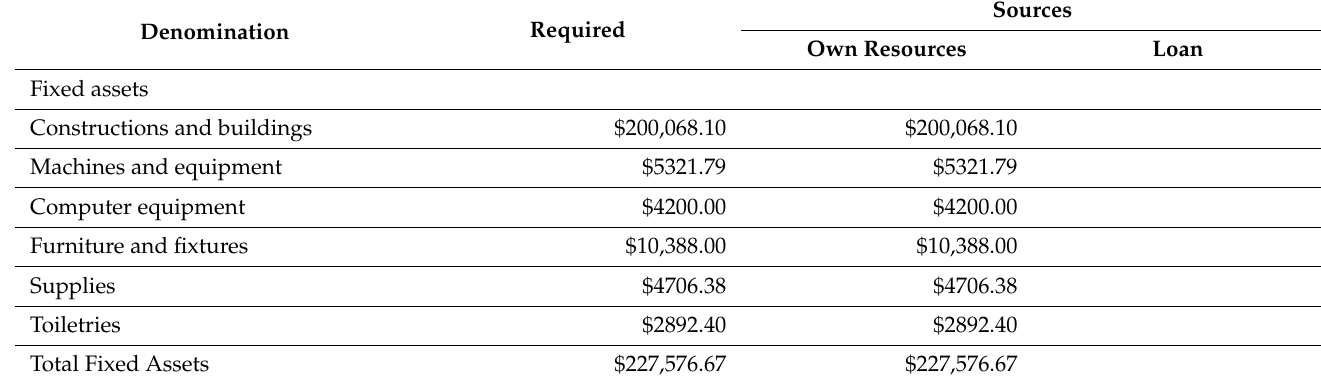
Table 5. Sources of